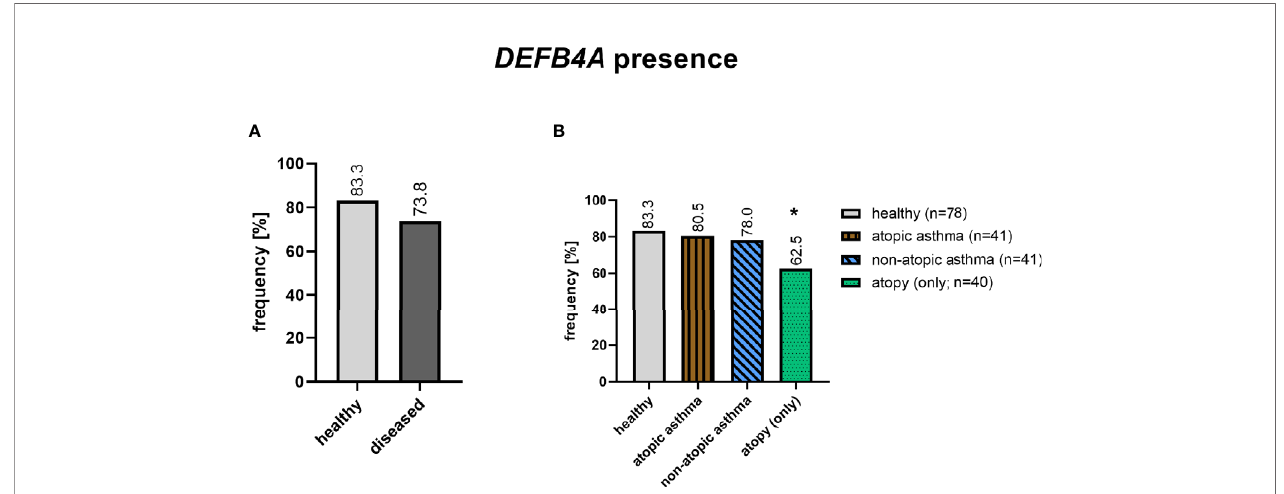
FIGURE 2 | Presence of DEFB4A in healthy (n=78) and diseased (n=122) subjects after RFLP assay for DEFB4A and DEFB4B . The diseased group include 41 non- atopic asthmatics, 41 atopic asthmatics and 40 atopics. * p =0.012 (chi-square test).